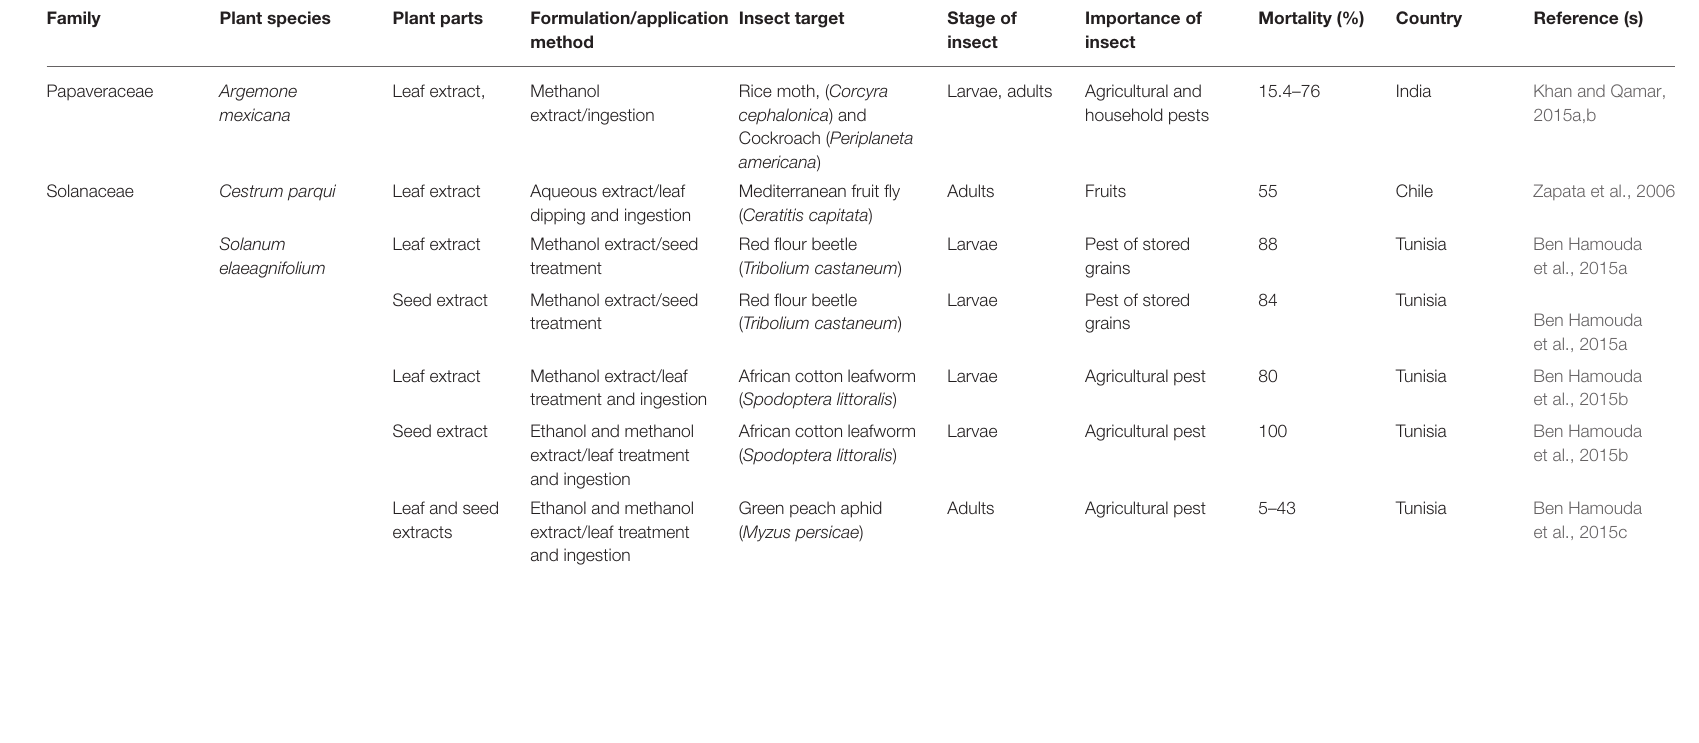
TABLE 2G | Published reports on the insecticidal activities of some plant species with invasive potentials in sub-Saharan